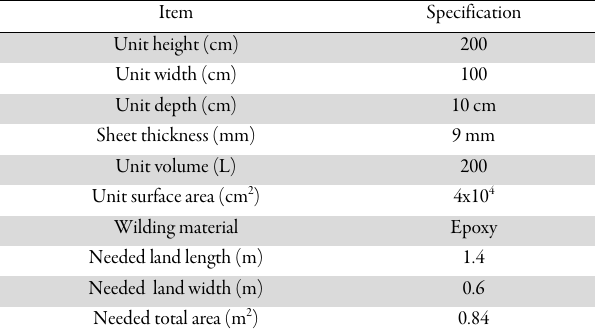
Table 1. Technical specifications of open sheet (indoor bioreactor) Table 2. Technical specifications of open plate